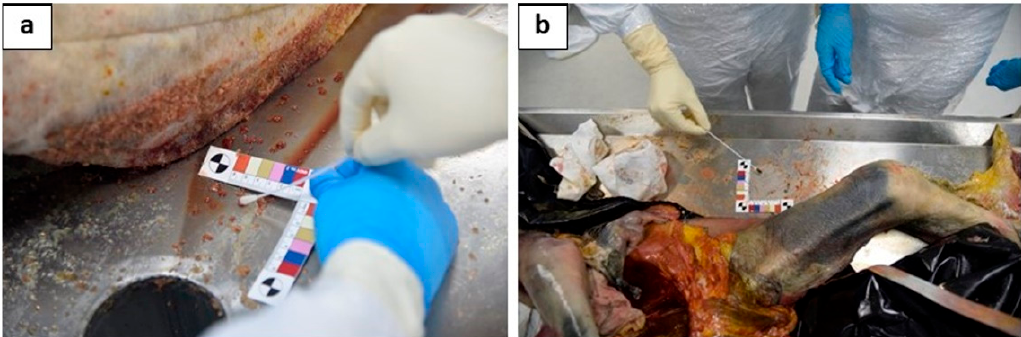
Figure 3. The particular of the sampling of the 2 swabs performed on the autopsy table: one performed 40 cm from the head on a surface of 6 cm 2 , near to the right upper arm ( a ); (2) another one performed 40 cm from the left arm on an area of 6 cm 2 , near to the left femur( b ). FS (2 swabs in total) of forensic pathologists who made the section of the cadaver on a surface of 6 cm 2 . FS1 was the face shield of the forensic pathologist to the right side of